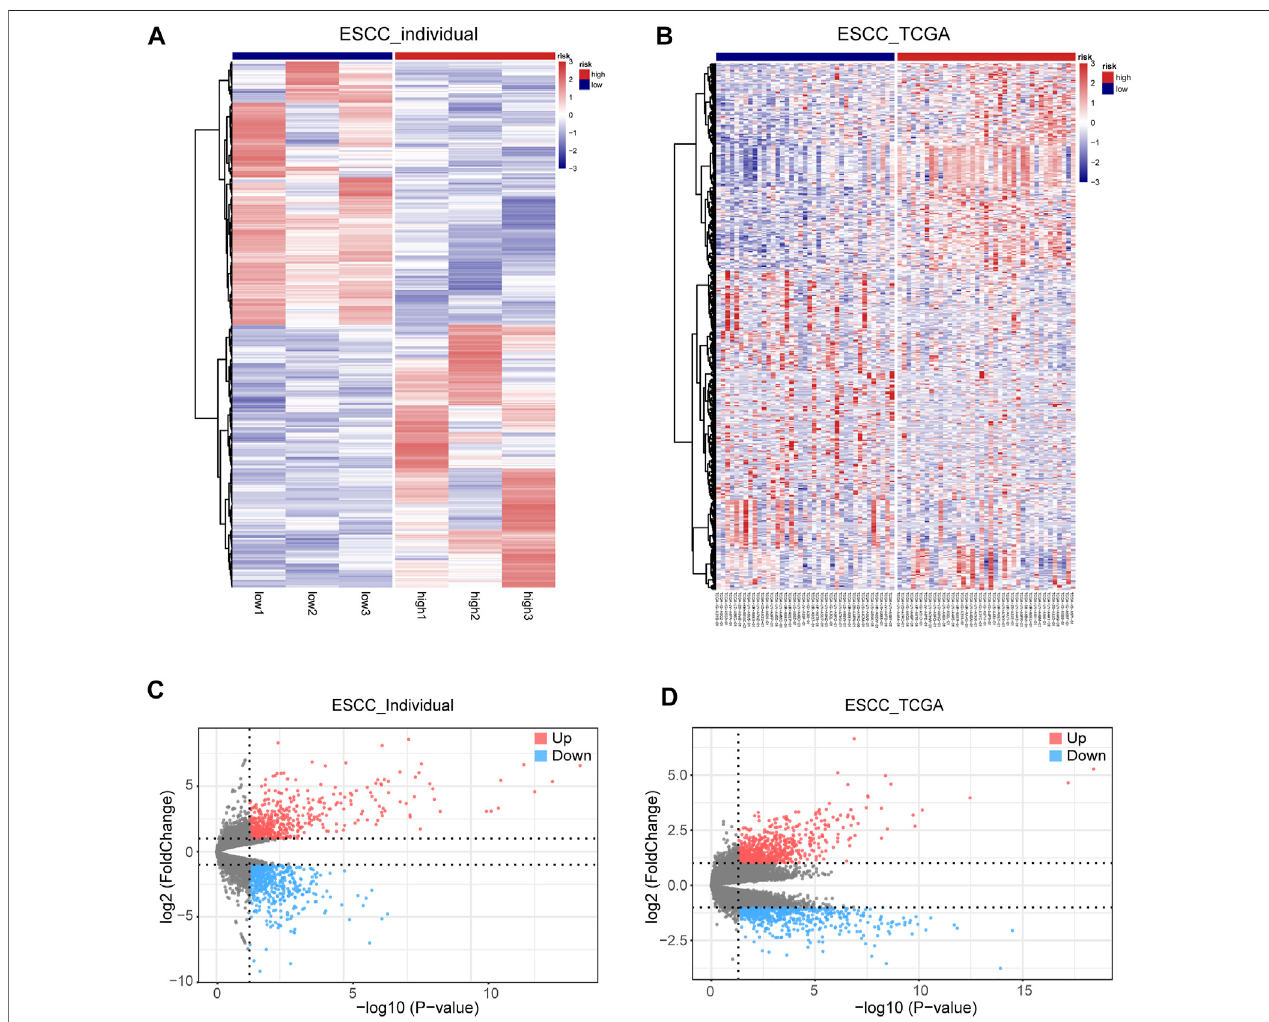
FIGURE 3 | The condition of differential expression of high SPOCD1 expression group and low SPOCD1 expression group. (A,B) The heat map of differentially expressed genes in high and low SPOCD1 expression was divided into two groups according to the median value of SPOCD1. Red represents upregulated differential genes, and blue represents downregulated differential genes; (C,D) The volcano map of differential genes showed that red represents upregulated differential genes, blue represents downregulated differential genes, and gray represents non-differential genes. SPOCD1, SPOC Domain Containing 1; ESCC, esophageal squamous cell carcinoma; TCGA, The Cancer Genome